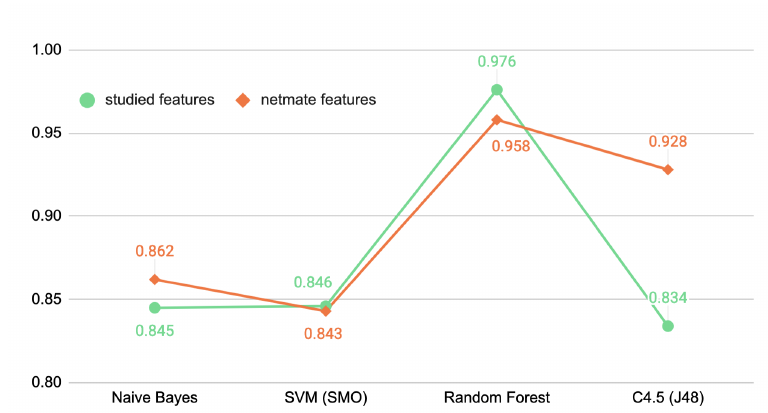
Figure 10. Average precision of the classifiers on both sets of features.